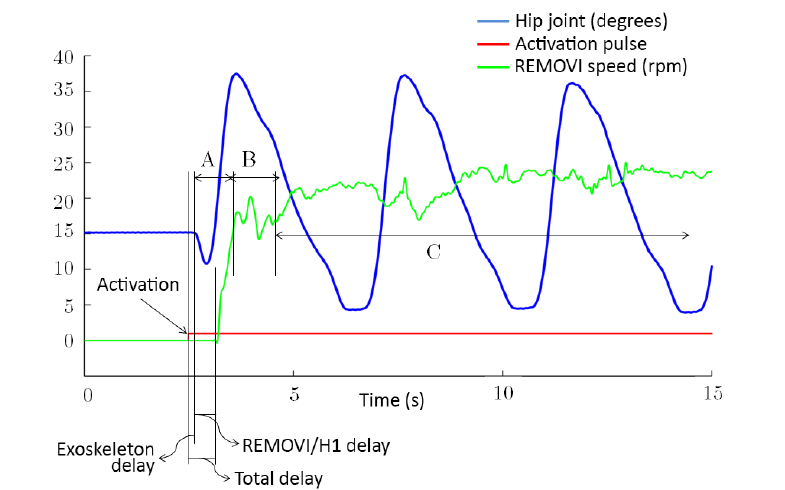
Figure 15. H1–REMOVI synchronization